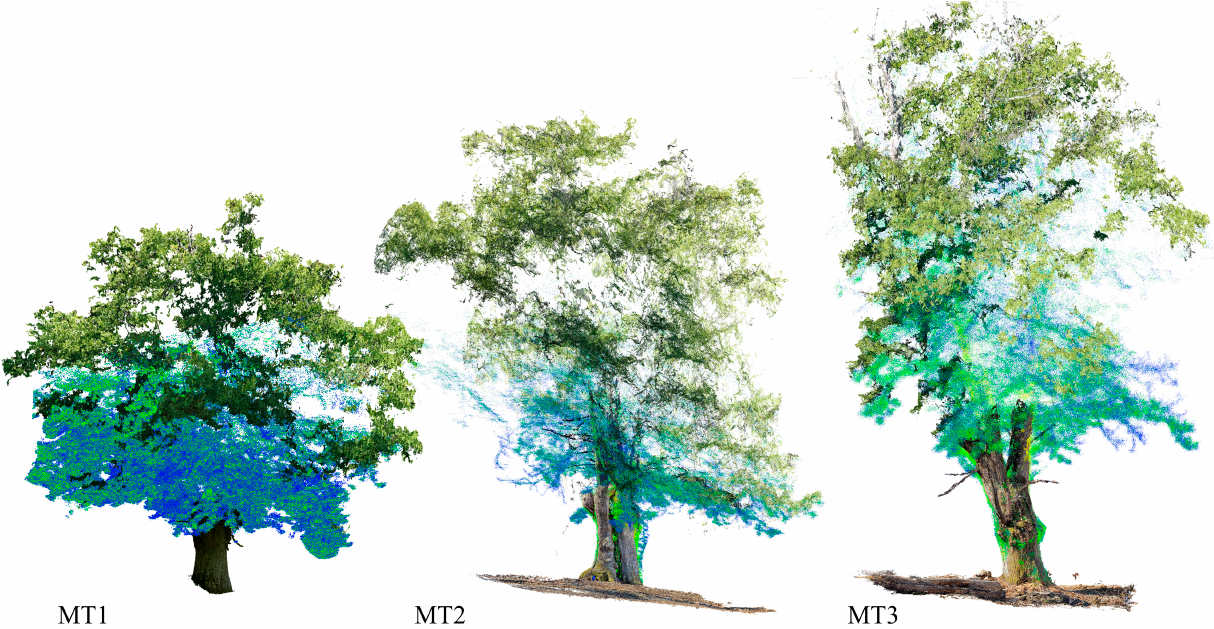
Figure 5. A view of the 3D tree models of the three monumental trees (MT1, MT2 and MT3) obtained fusing SLR dense cloud, MLS point cloud and UAV dense cloud.